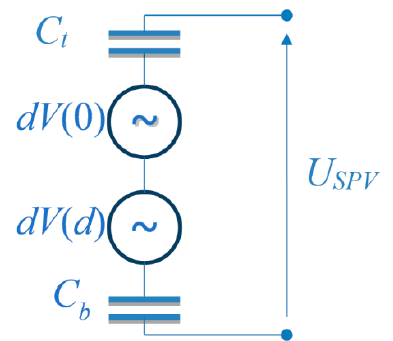
Figure 3. The electrical model of the SPV signal generation system in a situation where both surfaces are signal sources.